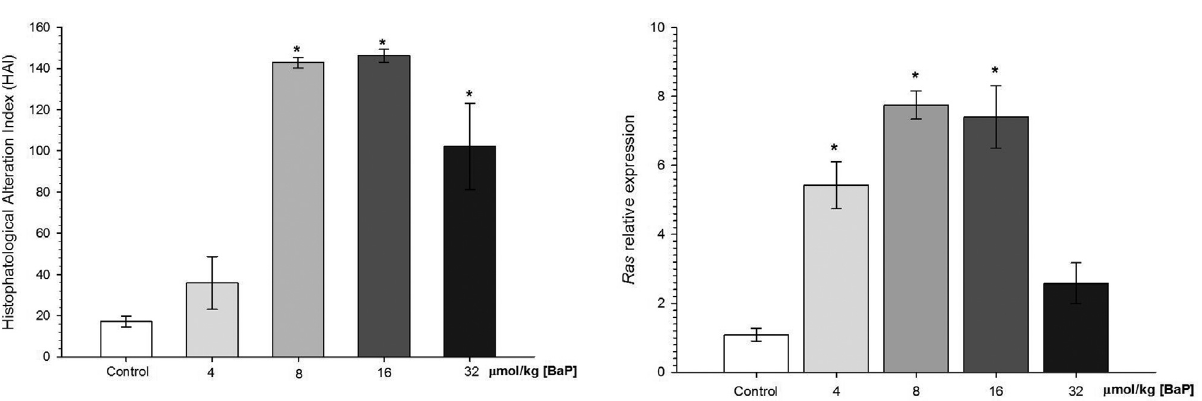
Figure 4 - Relative expression of the oncogene ras in liver of C. macropomum after 96 h of injection of different concentrations of B[a]P. *Indicates significant difference in comparison to control group (p < 0.05). Kruskal-Wallis test was used.